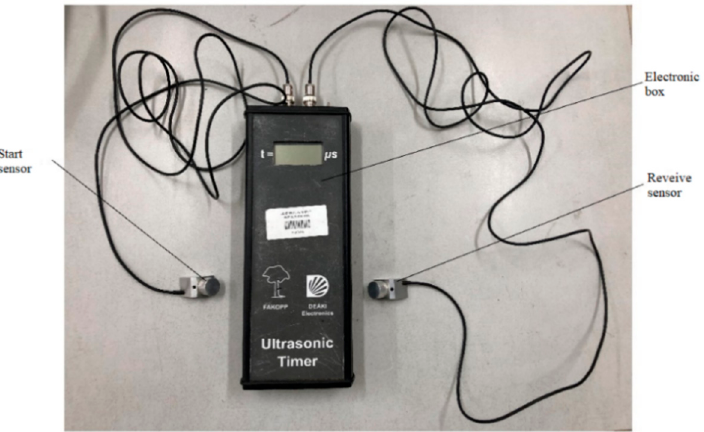
Figure 2. Fakopp ultrasonic timer.